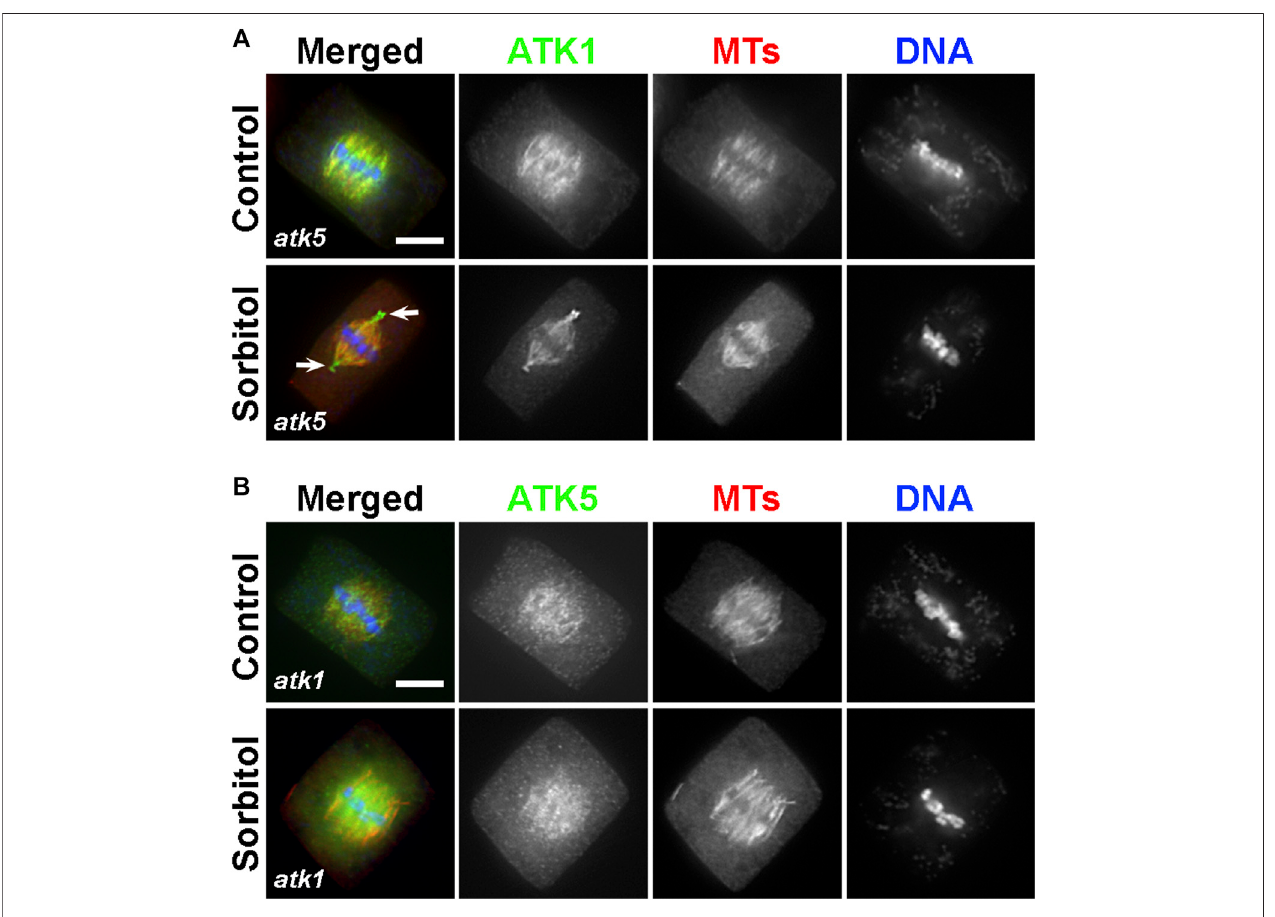
FIGURE 8 | ATK1 and ATK5 associate with spindle MTs independently. (A) In the atk5 background, ATK1-GFP localizes along spindle MTs and becomes highly enriched after sorbitol treatment at pseudo-centrosome foci that do not have obvious MT enrichment. (B) In the atk1-1 background, ATK5-GFP still decorates spindle MTs but does not form pseudo-centrosomes after sorbitol treatment. Scale bars, 5 µm.